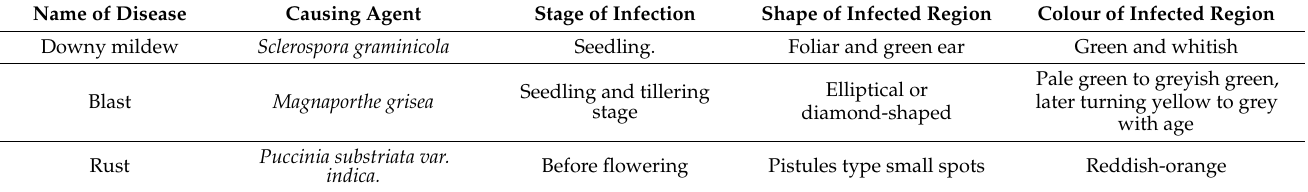
Table 1. Characteristics and symptoms of diseased leaves of pearl